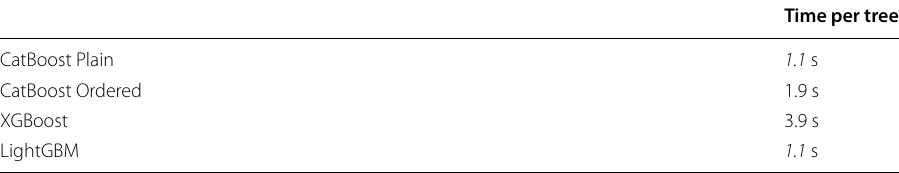
Italic text from the original work, indicates shortest tree construction